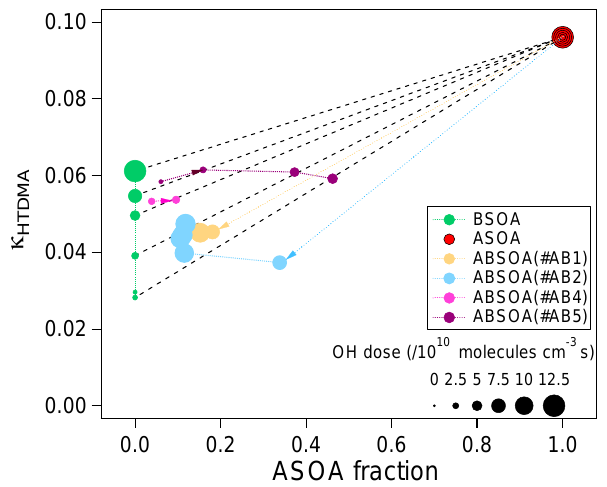
Figure 6. κ HTDMA of ABSOA as a function of ASOA fraction. The size of the marker denotes the OH dose. For ASOA, κ HTDMA is largely independent of OH dose and the average value was used, shown as the same point for different OH dose. The dashed lines connecting the pure BSOA and ASOA of the same OH doses stand for the linear combination of the κ HTDMA of pure BSOA and pure ASOA at that given OH dose. A data point beyond the line corresponding to the OH dose of that point indicates a non-linear effect. The cases of non-linear effect can be found for ABSOA #AB1, #AB2 and #AB5. The dotted lines with arrow of ABSOA show the time order of data points.